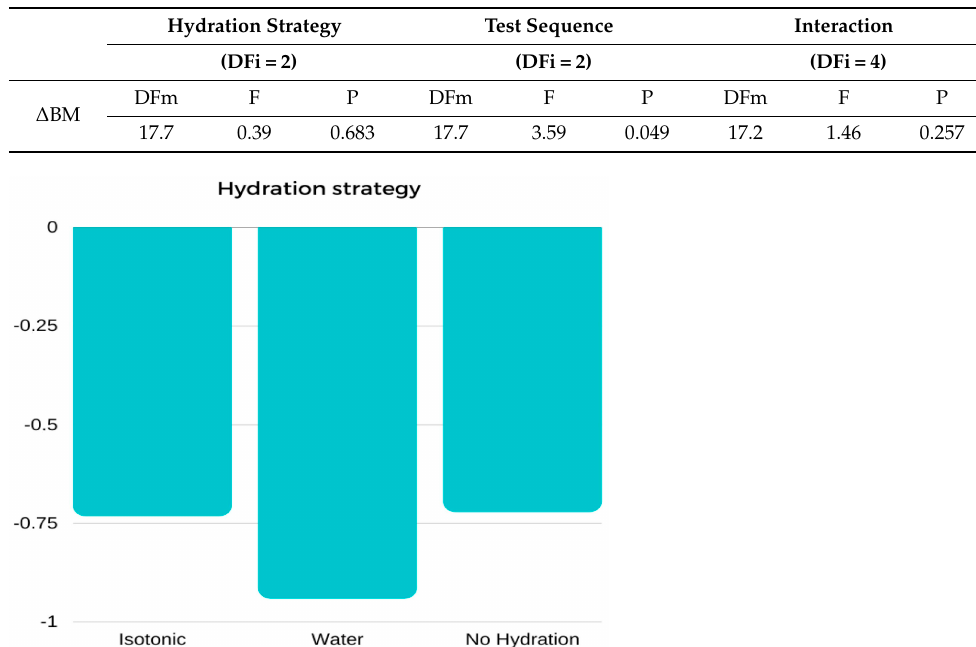
Table 3. Results of analysis of variance for the change in body mass ( ∆ BM) between the pre-test (preT) and post-test (postT) results of the exercise test: significance of (P) and F-statistic along with the number of degrees of freedom (DFi—in the numerator; DFm—in the denominator) for the fixed effects (hydration strategy, test sequence, and their interaction).